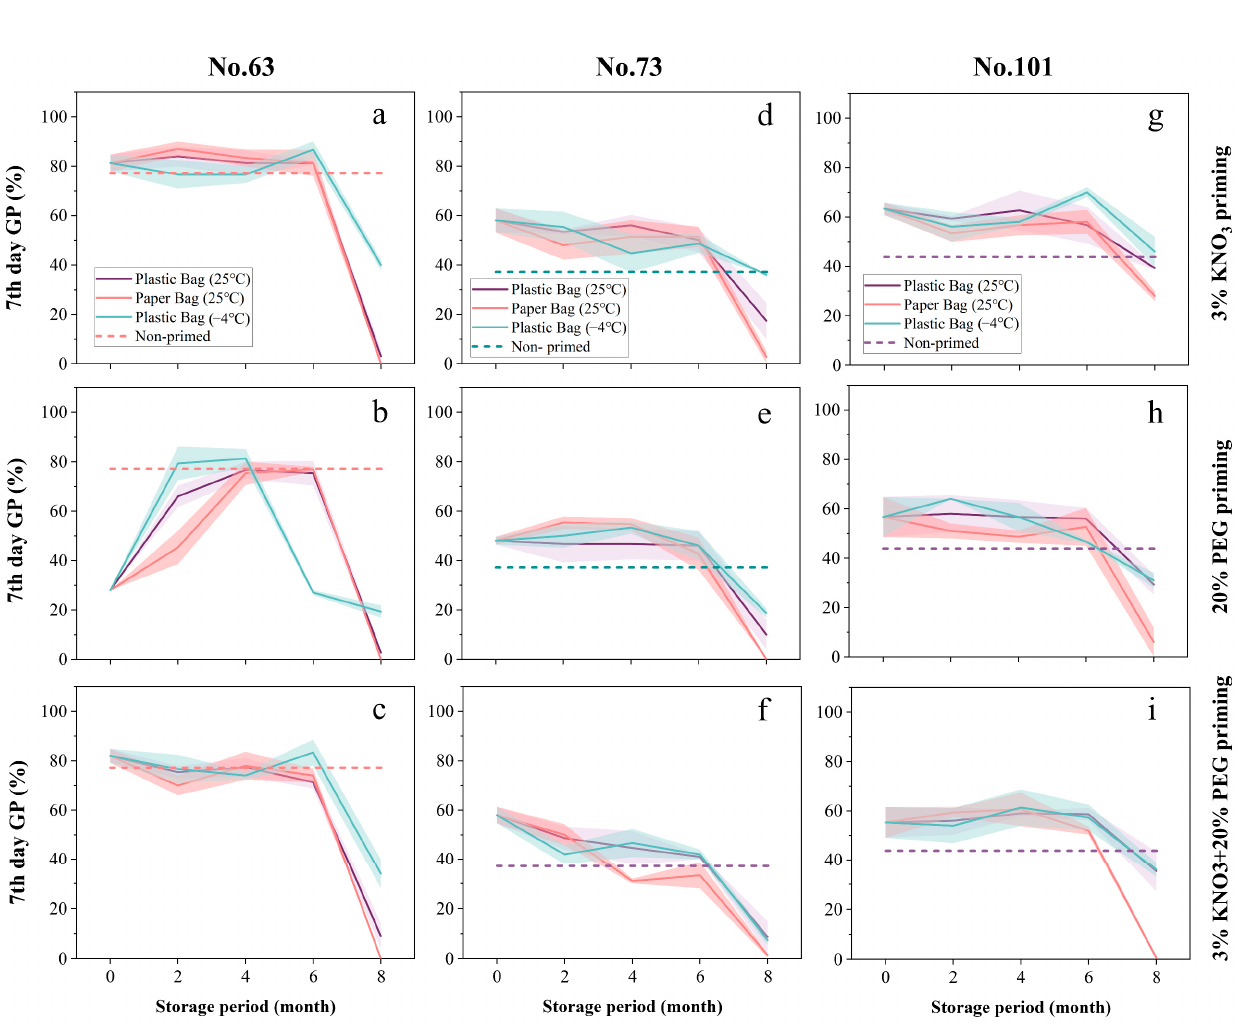
Figure 3. The 7th day germination percentage of primed pepper seeds in different storage conditions over time. GP: germination percentage. ( a – c ) the germination percentages for No.63 pepper seeds; ( d – f ) the germination percentages for No.73 pepper seeds; ( g – i ) the germination percentages for No.101 pepper seeds. ( a , d , g ) 3% KNO 3 priming; ( b , e , h ) 20% PEG priming; ( c , f , i ) 3% KNO 3 + 20% PEG priming. The light-shaded area around the curve represents the standard error.